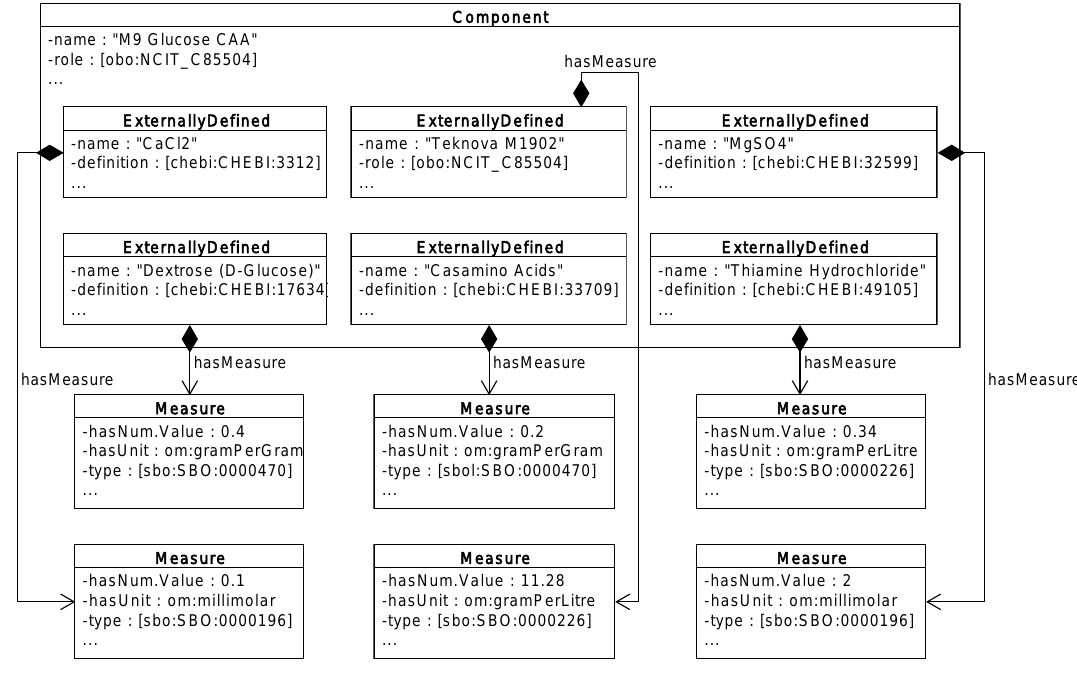
Figure 30: Growth media recipe represented using instances of the om:Measure and om:Unit classes from the OM.